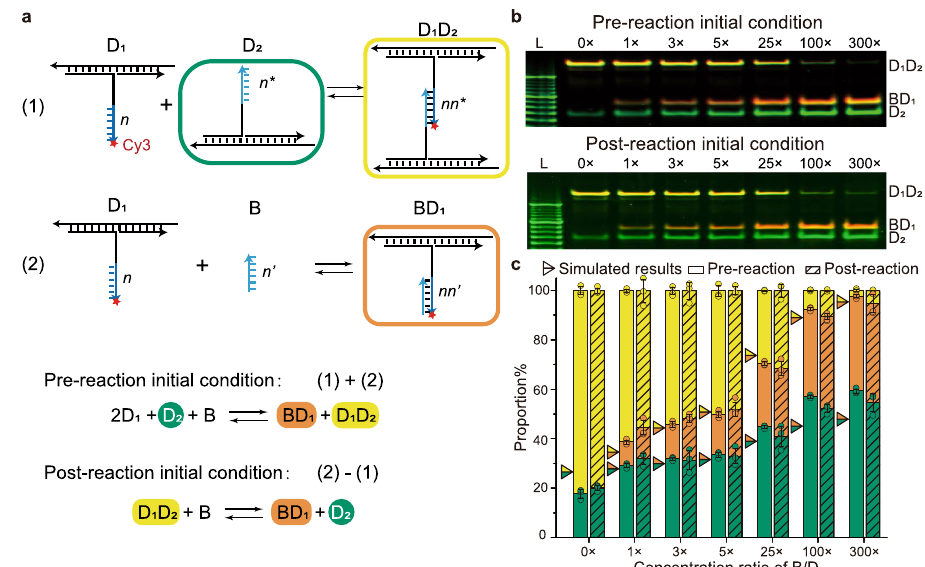
Fig. 2 Proof-of-concept system of toehold-free strand displacement. a Schematic diagram of reaction. Reaction (1): binding of D 1 and blocker. Reaction (2): binding of D 1 and D 2 . Details in Supplementary Note 1 and Supplementary Figs. 1 – 14. Green square highlights D 2 , yellow square highlights D 1 D 2 and orange square highlight BD 1 . The same color theme applies to all panels across this fi gure. b PAGE results of pre-reaction and post-reaction initial condition at 40 °C with concentration gradient of blocker from 0 × to 300 × (1 × = 125 nM). Three independent experiments were repeated (detailed statistics in Supplementary Figs. 3 and 5). c Statistical analysis from PAGE results (mean ± SD, N = 3) and the corresponding simulations. Unshaded bars: pre-reaction initial condition; shaded bars: post-reaction initial condition; triangles: simulated results from reaction equilibrium